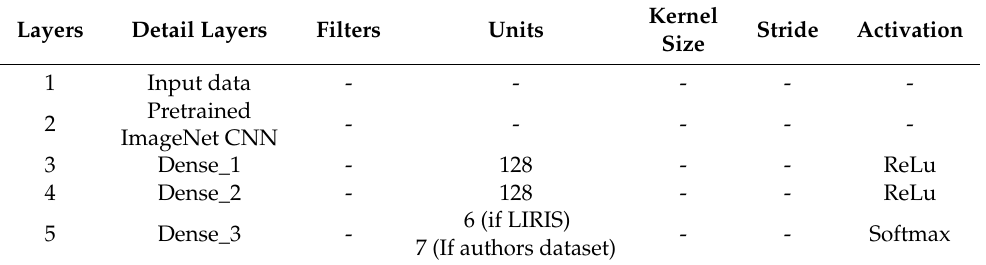
Table 6. CNN models’ detail.